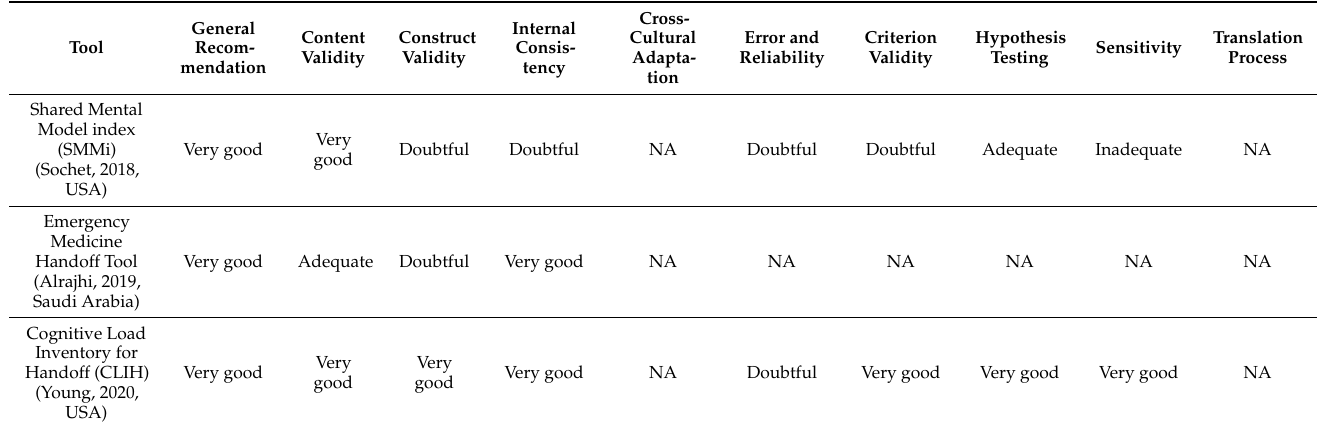
Table 3. Methodological quality of the psychometric properties of the assessment tools: COSMIN (23). Tortosa, ESP, Spain, 2021.